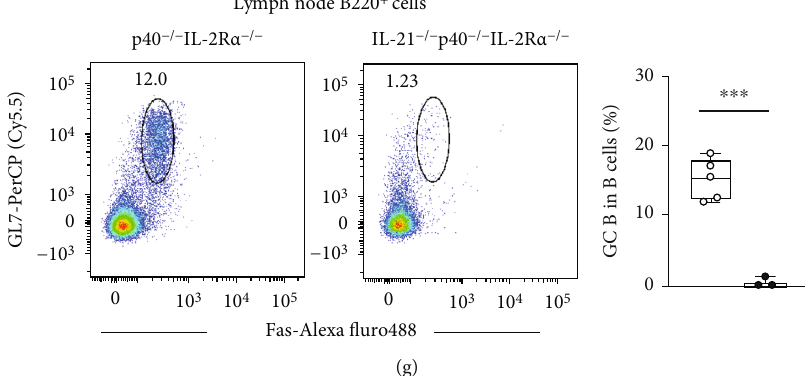
Figure 4: Autoimmune cholangitis in IL-21 -/- p40 -/- IL-2Ra -/- mice. (a) Serum AMA levels in IL-21 -/- p40 -/- IL-2Ra -/- ( n = 4 ) and p40 -/- IL- 2Ra -/- ( n = 4 ) mice. (b) Representative H&E of the liver at 100x and 400x magni fi cation. (c) Liver pathological score of IL-21 -/- p40 -/- IL- 2Ra -/- ( n = 5 ) and p40 -/- IL-2Ra -/- ( n = 6 ) mice. (d) Densities of liver MNCs in IL-21 -/- p40 -/- IL-2Ra -/- ( n = 6 ) and p40 -/- IL-2Ra -/- ( n = 12 ) mice. (e) Numbers of T cells in the liver from IL-21 -/- p40 -/- IL-2Ra -/- ( n = 6 ) and p40 -/- IL-2Ra -/- ( n = 12 ) mice. (f) Percentages and numbers of CD4 + T cells in the liver from IL-21 -/- p40 -/- IL-2Ra -/- ( n = 6 ) and p40 -/- IL-2Ra -/- ( n = 12 ) mice. (g) Representative fl ow cytometry plots and percentages of GC B cells in lymph nodes from IL-21 -/- p40 -/- IL-2Ra -/- ( n = 3 ) and p40 -/- IL-2Ra -/- ( n = 5 ) mice. ∗ p < 0 : 05, ∗∗ p < 0 : 01, and ∗∗∗ p < 0 : 001